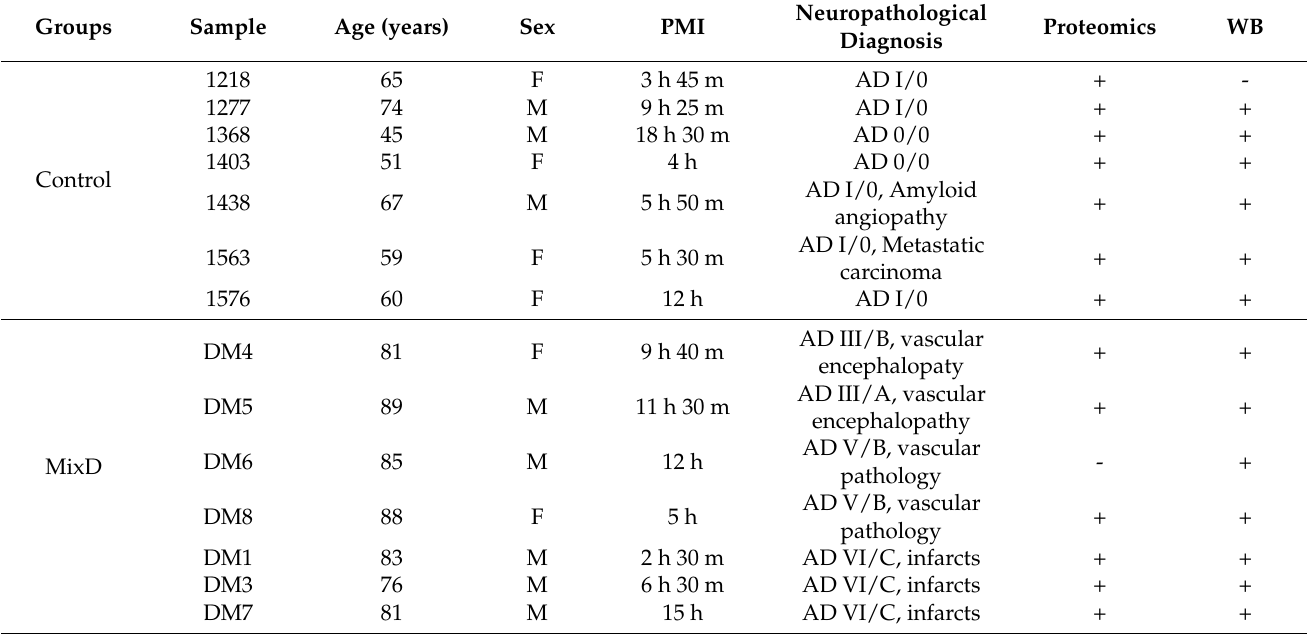
Table 1. OB samples from MixD patients and controls. F (female), M (male), PMI (post-mortem interval), WB (Western Blot). Groups